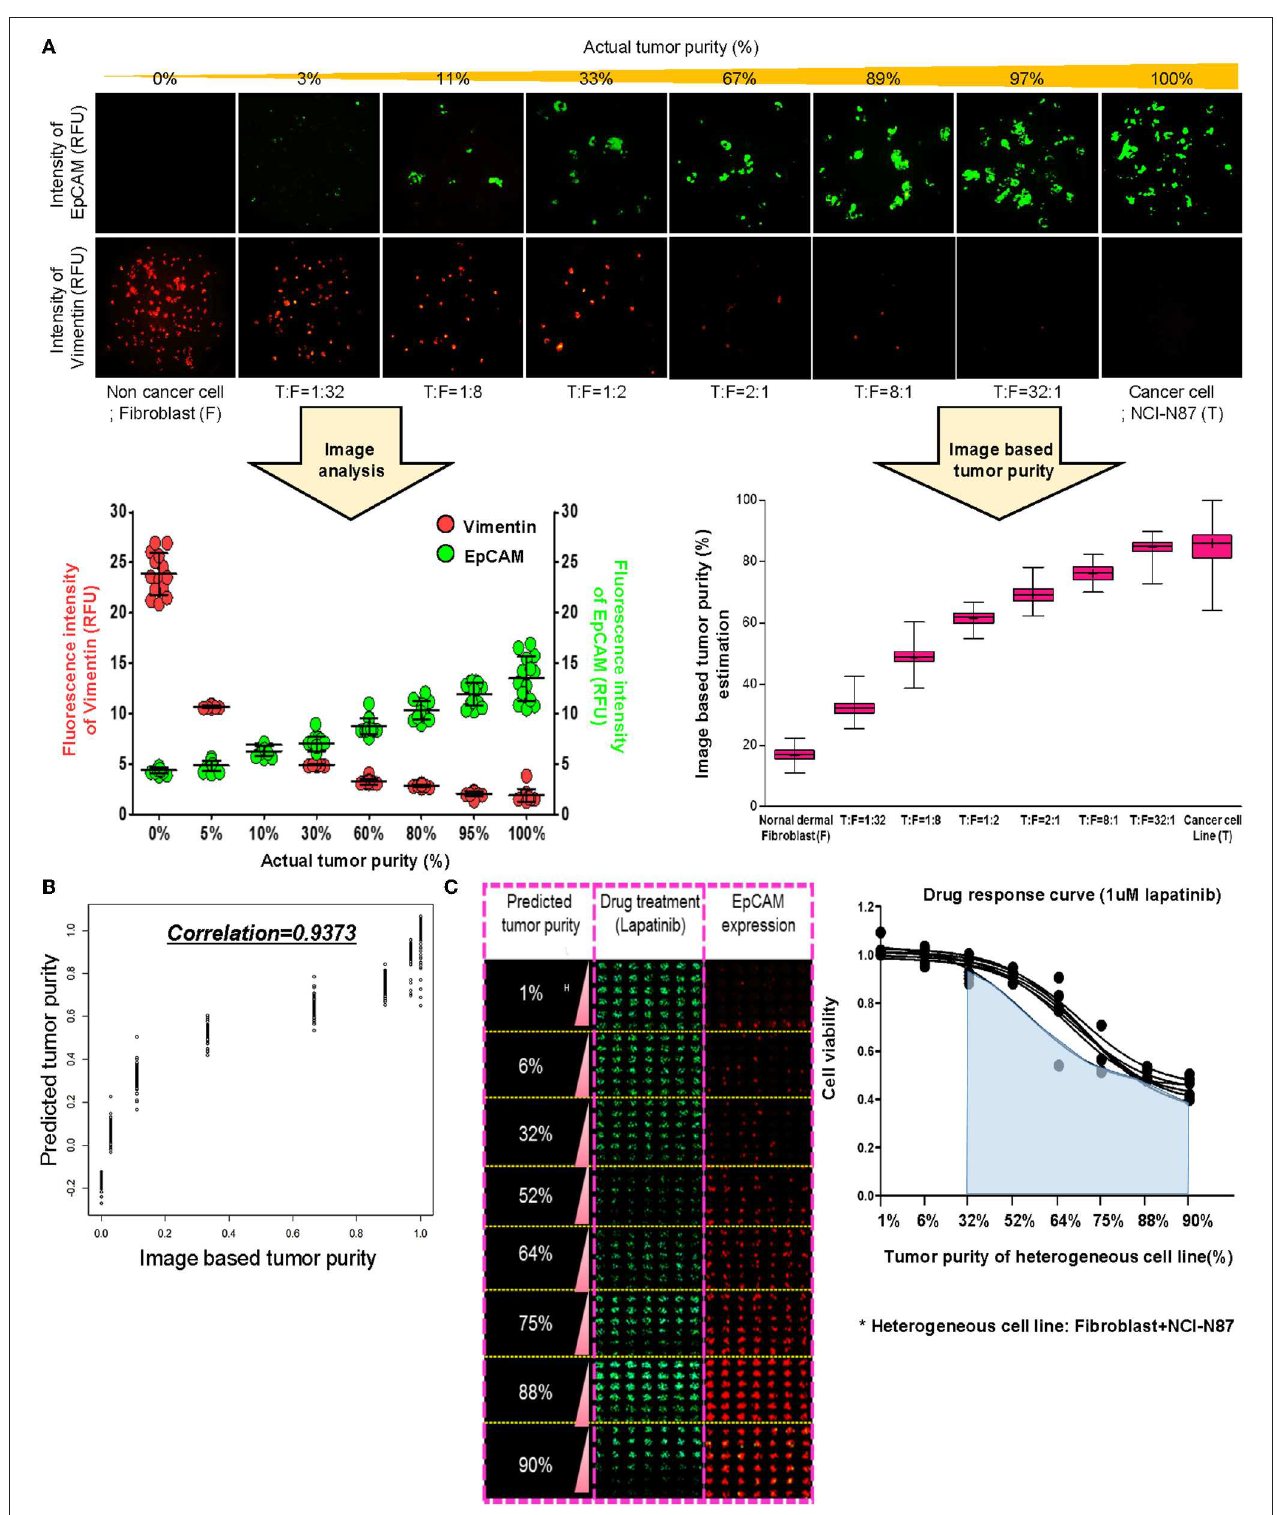
FIGURE 2 | Prediction of tumor purity based on immunofluorescence-based image analysis for gastric PDCs (A) Conditions of the various heterogenous cell lines combining NCI-N87 cancer cells with fibroblasts and the fluorescence intensity imaging results. Increased fluorescence intensity of EpCAM and decreased fluorescence intensity of vimentin with increasing concentrations of actual tumor content. Actual tumor purity in mixed cancer cells is calculated as the ratio of EpCAM intensity to combining EpCAM and vimentin intensity. (B) From this ratio, the predicted model of tumor purity in PDCs was derived, and the correlation R 2 was 0 · 9373. (C) Drug response curve with lapatinib and various conditions of actual tumor purity in mixed cells.